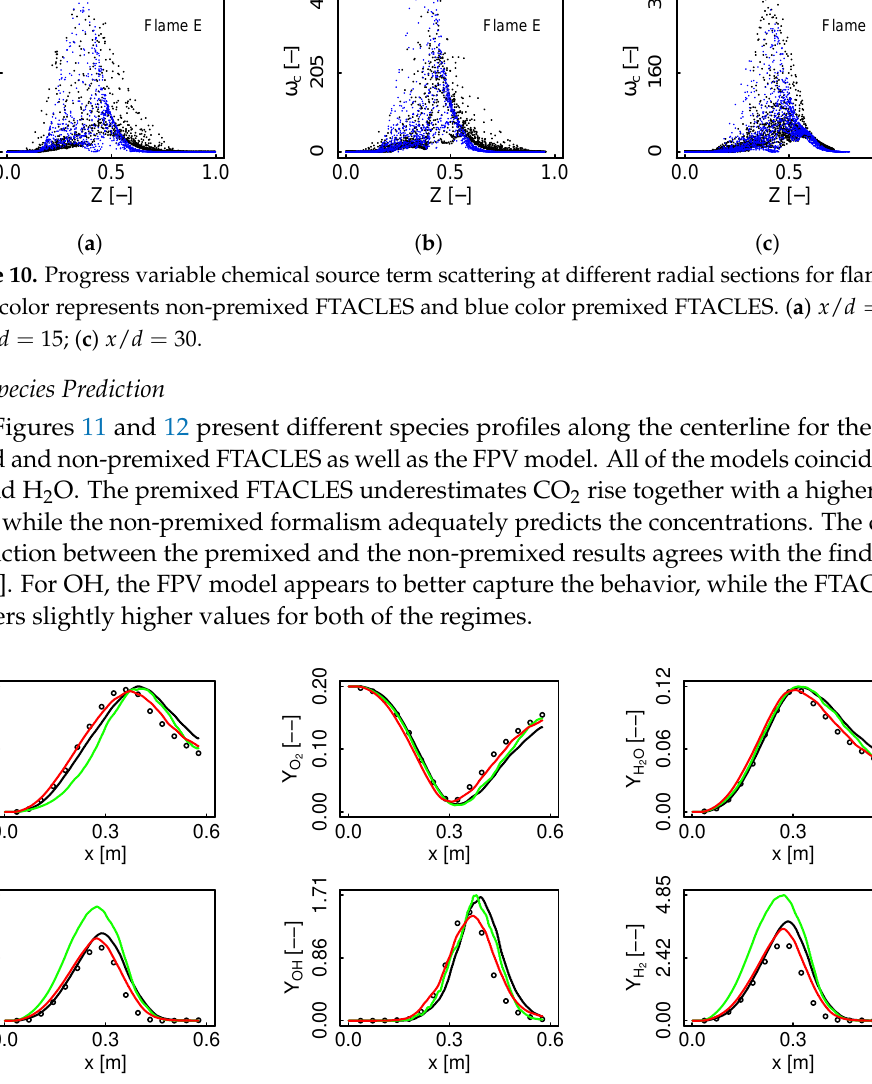
Figure 11. Species profiles comparison along the centerline for flame D. Black color represents non-premixed FTACLES, green color premixed FTACLES, red color FPV, and circles depict the experimental